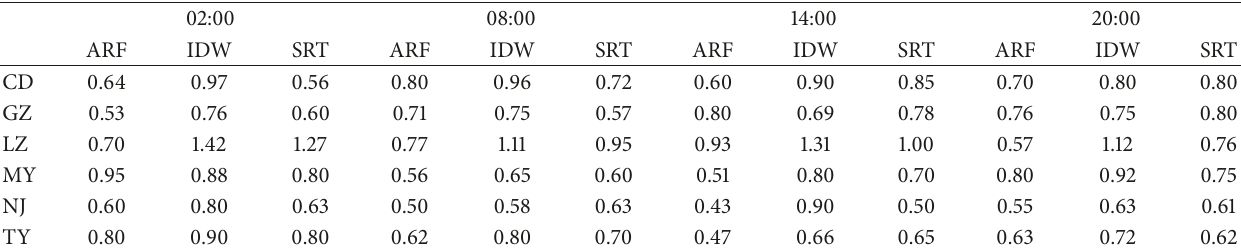
Table 1: QC parameters for CD, GZ, LZ, MY, NJ, and TY stations at 02:00, 08:00, 14:00, and 20:00.